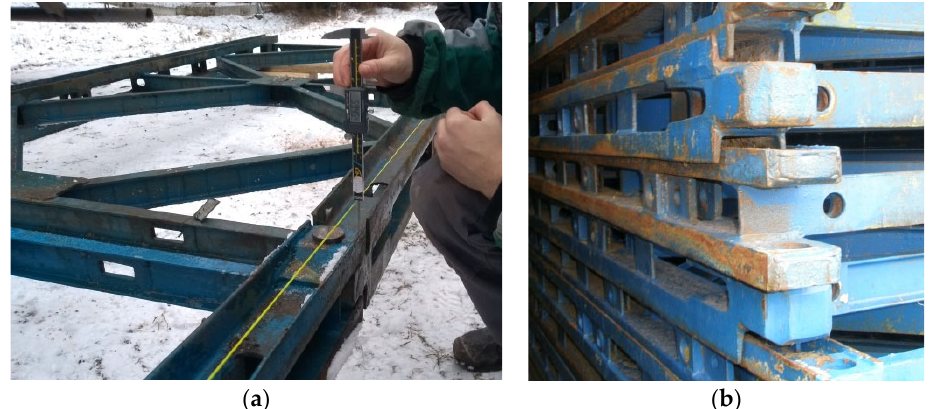
Figure 14. In situ verification of pin joint dimensions and its deformation capacity in horizontal direction: ( a ) measurement of horizontal deformation capacity of the joint; and ( b ) stored Bailey bridge panels.